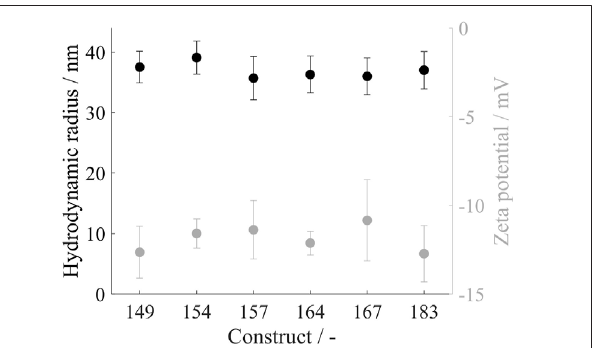
FIGURE3| Hydrodynamicradiusinblackandzetapotentialingreyofall VLP construct capsids. Measurements were conducted directly